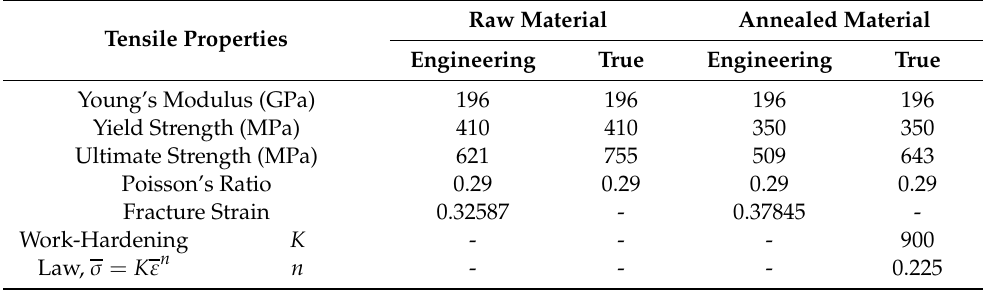
Table 1. Mechanical properties of AISI 1035 medium carbon steel as the cold-drawn round